Question: Provide a one-line summary of what is displayed.
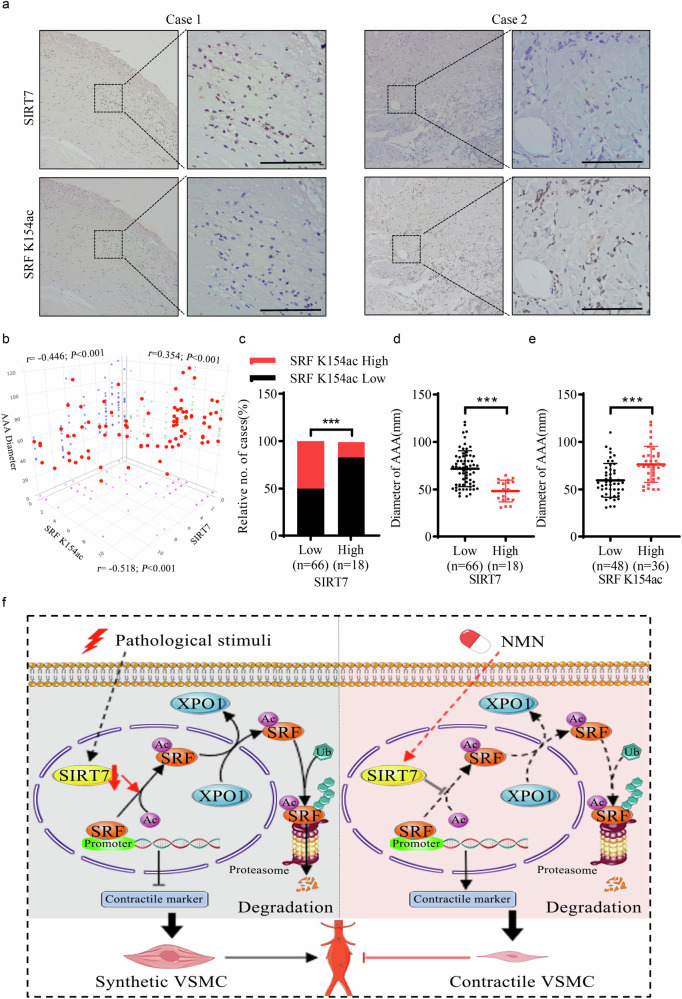
Answer: SRF-K154 acetylation is upregulated in patients with AAA and negatively correlated with AAA diameter. a Representative image of immunohistochemical (IHC) staining for sirtuin 7 (SIRT7) and serum response factor (SRF)-K154 acetylation in patients with abdominal aortic aneurysm (AAA). Scale bar, 100 μm. b Scatter plot of the IHC staining scores for SIRT7, SRF-k154ac, and diameter of AAA in patients ( n = 84). c Quantitative IHC staining scores showing the correlation between SIRT7 and SRF-K154 acetylation. d-e The diameter of AAA in indicated groups according to IHC staining scores. f Schematic representation of the molecular mechanisms. Under pathological conditions of AAA formation, downregulation of SIRT7 increases SRF acetylation, suppresses SRF transcriptional activity, and promotes XPO-1-mediated SRF nuclear–cytoplasmic translocation, ultimately accelerating SRF ubiquitination and degradation. These events trigger vascular smooth muscle cell (VSMC) phenotypic switching, leading to AAA progression. Supplementation with nicotinamide mononucleotide (NMN), a precursor of NAD + biosynthesis, activates SIRT7, inhibits VSMC phenotypic switching, and attenuates AAA formation. Data are expressed as mean ± SD. All P -values and r -values were calculated with Spearman’s r test. Fisher’s exact test (part c ). Two-tailed paired Student’s t test (parts d and e ).